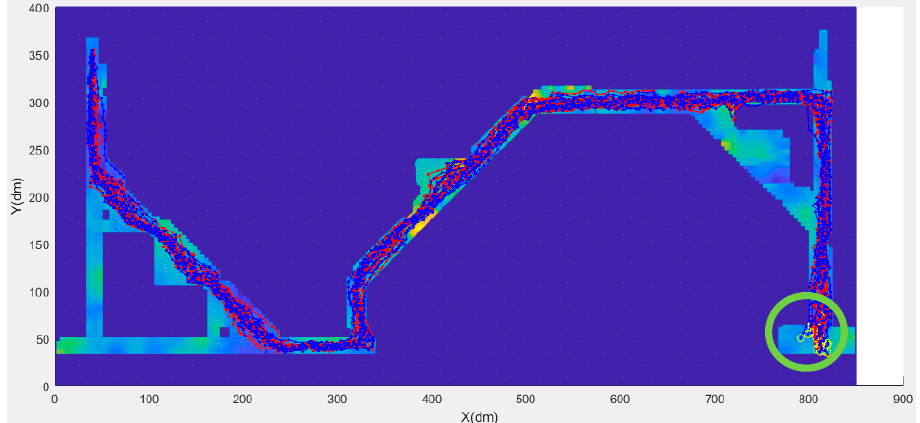
Figure 13. Test result of 30 users (forward).